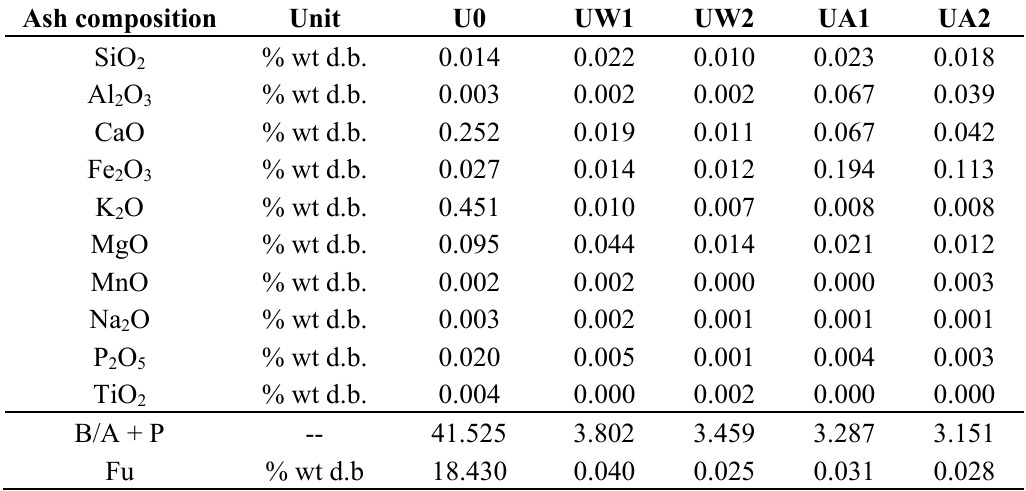
Table 2. Ash composition and evaluation of slagging and fouling tendency based on different indexes.